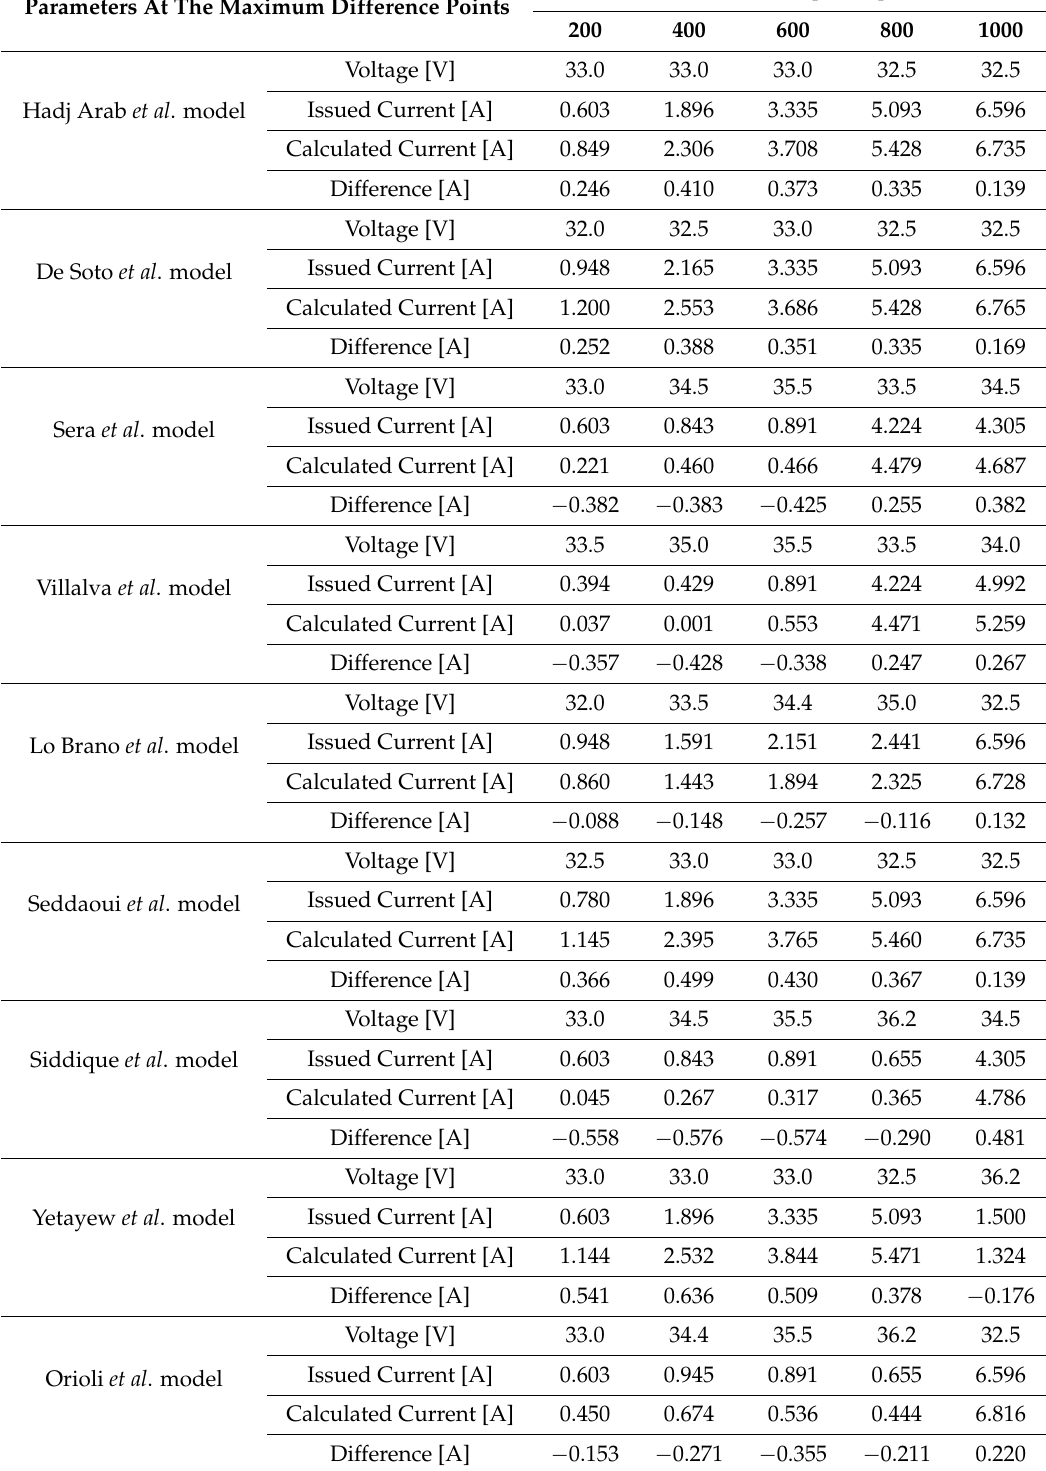
Table 7. Maximum current differences between the calculated and the issued I-V characteristics of Kyocera KD245GH-4FB2, at temperature T = 25 ˝